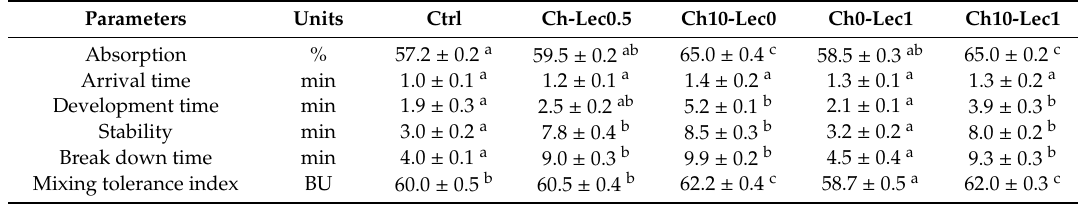
Table 2. Dough mixing properties of the di ff erent